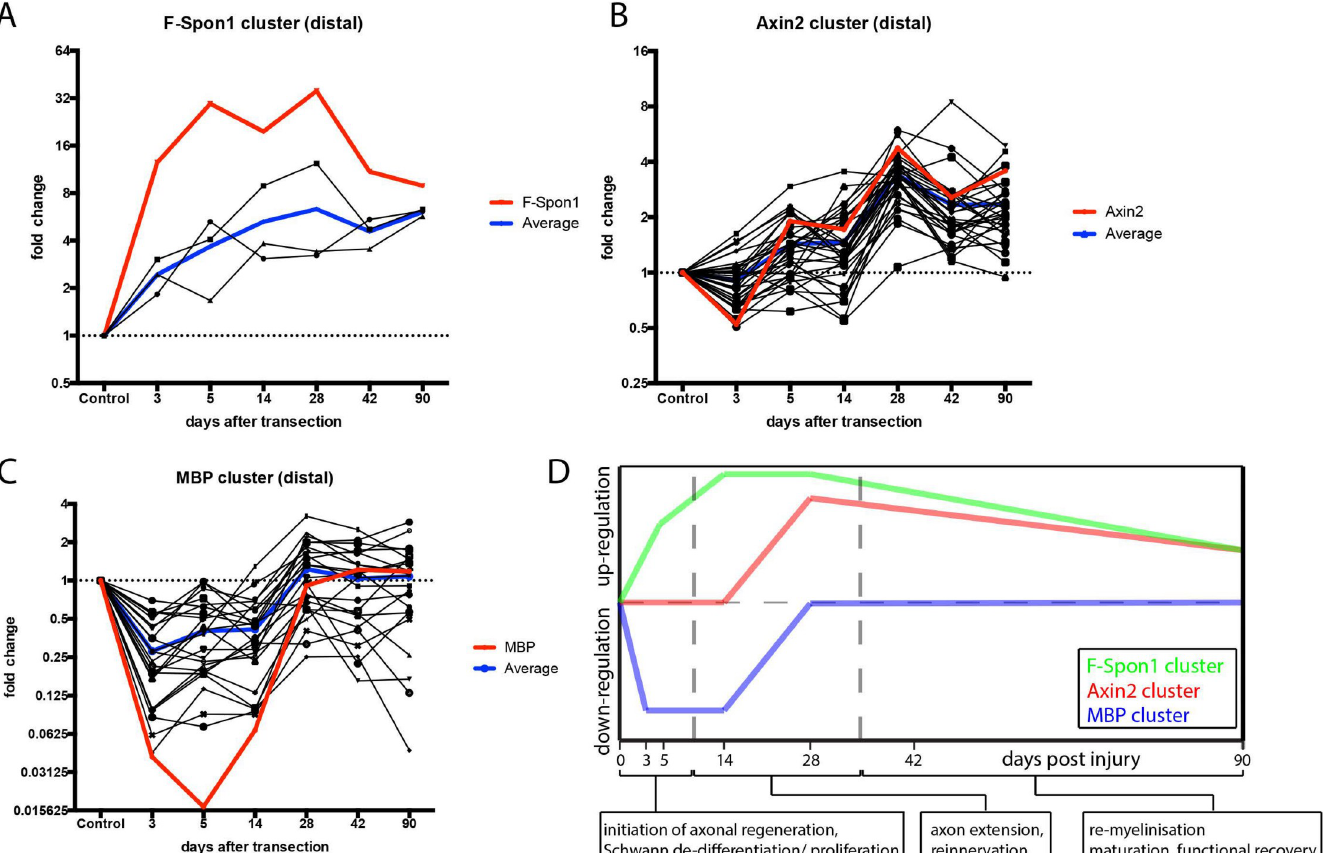
Fig 4. Wnt pathway gene clusters in the distal stump of the transected sciatic nerve. The temporal expression profiles of individual genes in the F-Spondin1, Axin2 and MBP clusters in the distal stump were plotted to visualize the coordinated nature of the expression of Wnt-pathway genes after nerve transection. Black lines represent individual genes, blue lines indicate average regulation and red lines indicate regulation of the marker gene (F-spon1, MBP) or the Wnt2b or Axin2 gene. A , The F-Spondin cluster contains genes which are up- regulated from early time points onward (3d p.i.) and remains up-regulated up to late (90d p.i.) timepoints. B , The genes in the Axin2 cluster exhibit an up- regulation at later time points (14–28d p.i.) and remain up-regulated up to 42 to 90d p.i. C , The MBP cluster consist of genes that are down-regulated at early timepoints (3 - 14d p.i.) and return to baseline around 28d p.i. D , Schematic representation of the F-Spondin1 (green), Axin2 (red) and MBP (blue) clusters with an indication of their correspondence to post-injury repair events in the peripheral nerve as indicated at the X-axis of the graph suggesting that these genes may have a role in these processes.